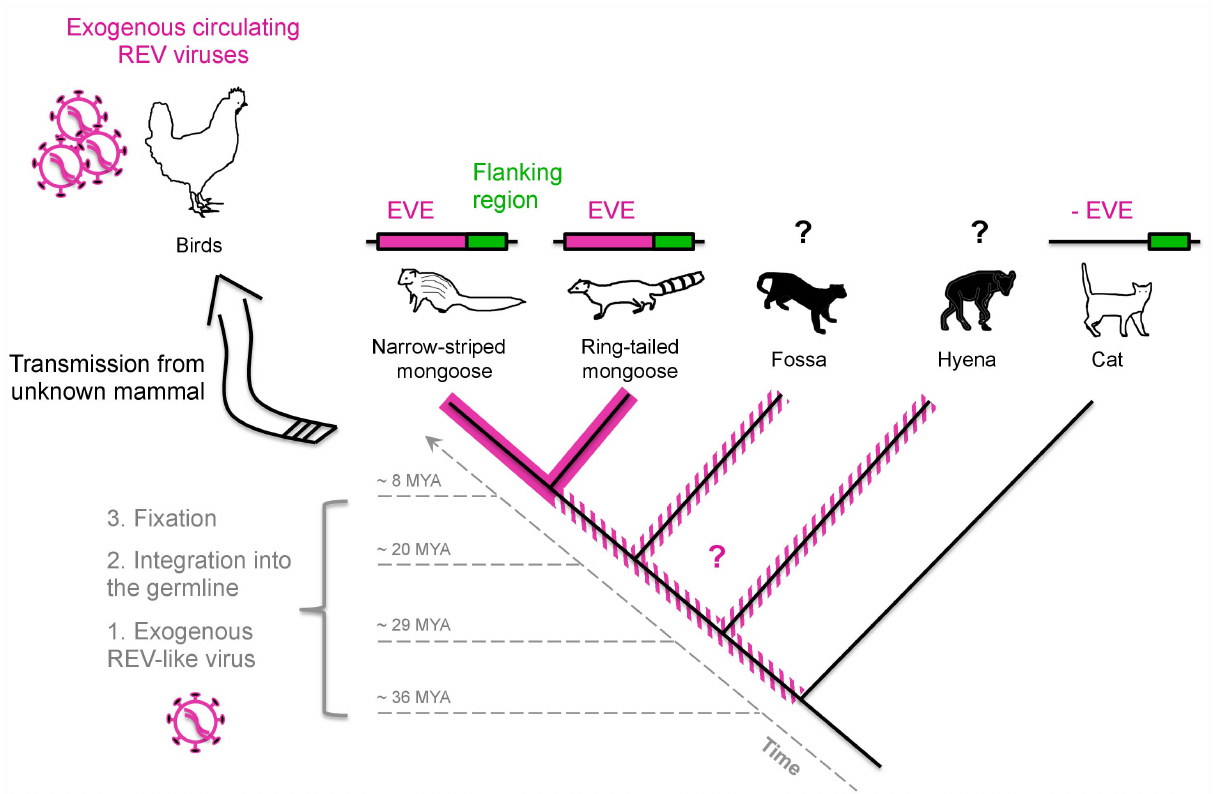
Figure 1. Paleovirology: How the study of endogenous viral elements (EVEs) informs us about the evolutionary history of modern viruses. The concept is illustrated with the example of the viral fossil record and evolutionary history of the reticuloendotheliosis virus (REV). The tree is a timescaled representation of a host genome phylogeny. Hosts for which genomic sequences are available are depicted in white, while hosts that do not have genome data available are represented in plain black. The hosts that harbor a REV-like endogenous element are depicted, as well as those from which information is not available (question marks) and others from which the EVE is absent. Regions in green represent the EVE flanking region. The time frame in which an exogenous mammalian virus (1), here REV, integrated in the host germline (2) and reached fixation (3) is represented. The presence of related EVEs at the same locus in both mongoose species shows that the insertion occurred before their divergence, approximately 8 million years ago (MYA), while the absence of EVE at this site in the cat species indicates that the insertion occurred after 36 MYA. Although not definitive, PCR for REV in fossa was negative [21]. Here, a more recent inter-class transmission from an unknown mammal was the origin of REV in birds. Image Credit: Lucie